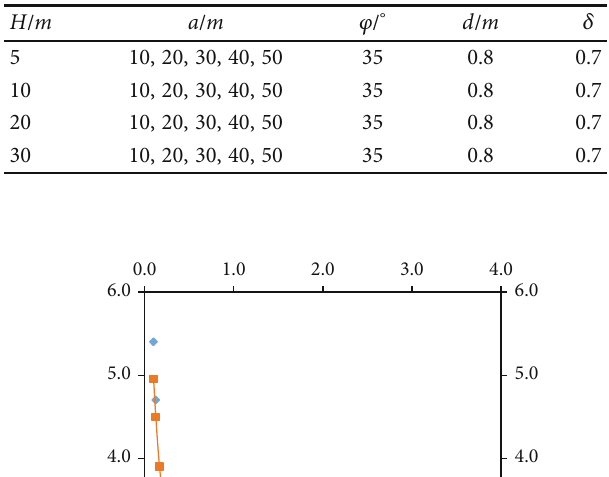
Table 3: Parameters of simulation.